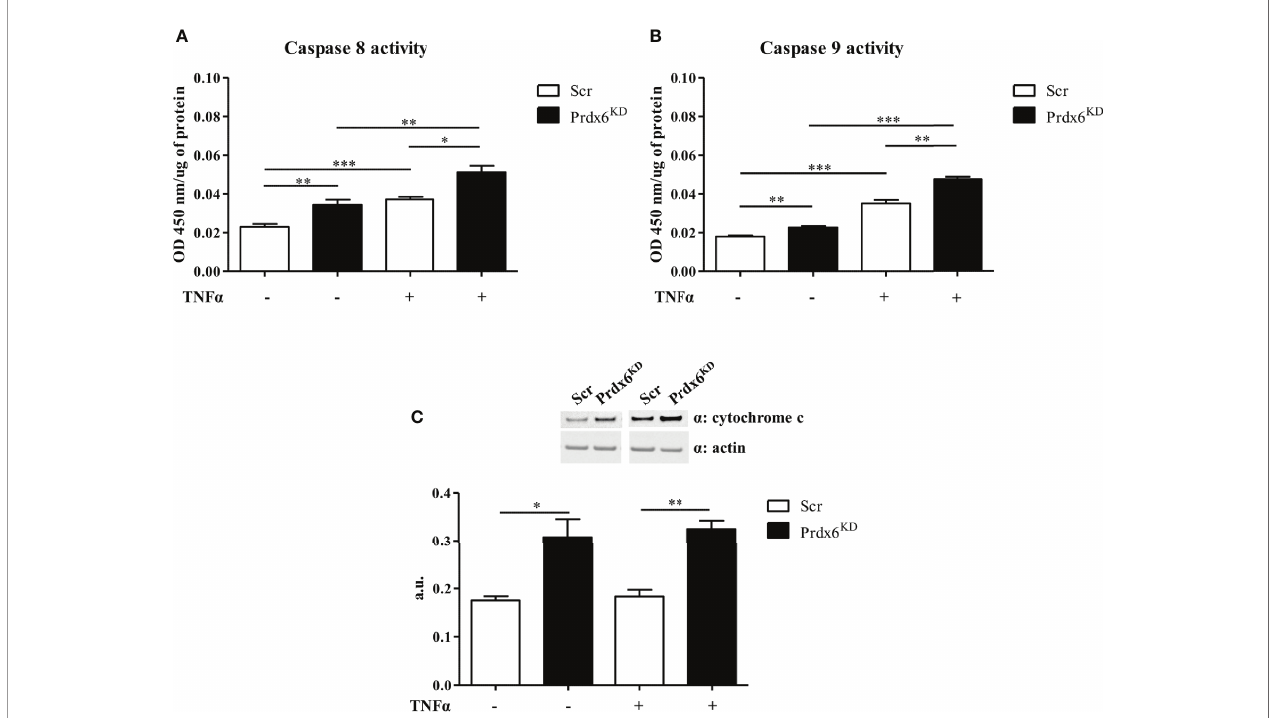
FIGURE 7 | Extrinsic and intrinsic apoptotic pathways following TNF- a administration. Caspase 8 (A) and caspase 9 (B) activity was measured in both Prdx6 KD (black- fi lled bar) and Scr (white- fi lled bar) following treatment with TNF- a . Cytochrome c expression levels (C) were also analyzed in the same experimental conditions. All values were normalized with actin as a loading control. All values are expressed as mean ± SEM. *p < 0.05, **p < 0.01, ***p < 0.001 (n = 5). a.u., arbitrary units.